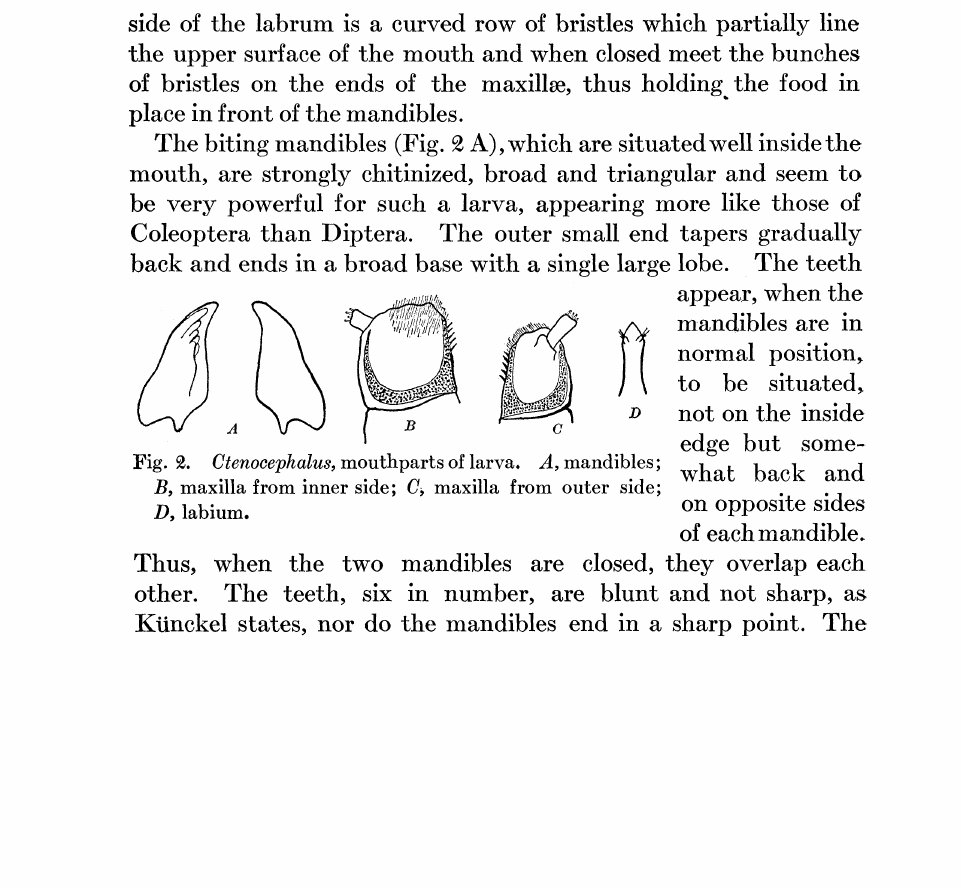
Fig. 1. Ctenocephalus fells, head of larva: A, ventral view; B, lateral view; C, dorsal view; ant., antenna; lb., labium; lbr., labrum; mx., maxilla; mx. pl., max- illary